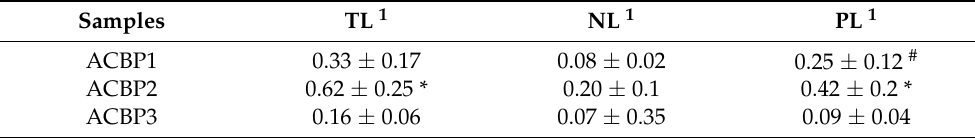
Table 1. Yield of TL, NL, and PL extracts from apple cider by-products ACBP1, ACBP2, and ACBP3, expressed as g/100 g 1